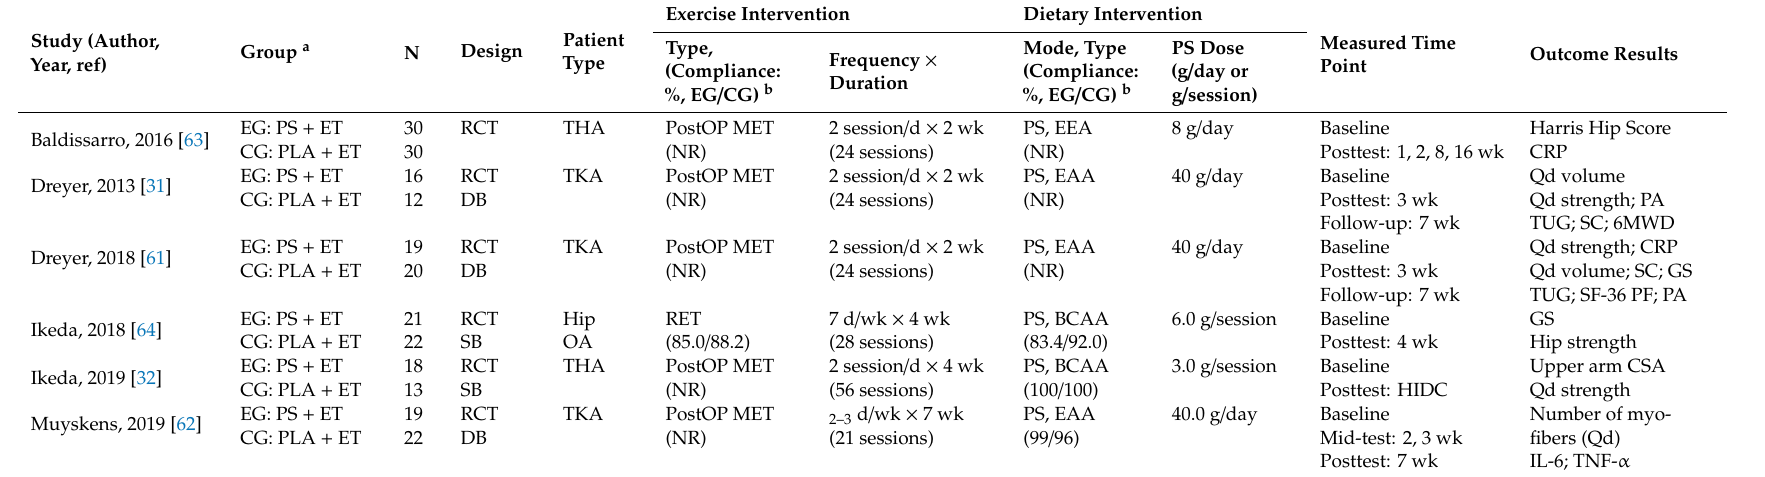
Table 1. Characteristics of the included